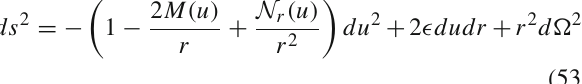
Fig. 4 The variation of R versus typical values of the L and N param- eters in (47) for the dust background. We have set M = 1 without loss of